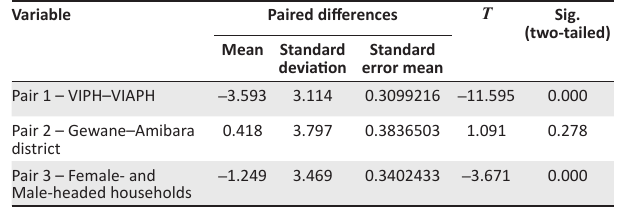
FIGURE 2: Vulnerability levels of households by district. TABLE 6: Paired sample tests for household vulnerability index clustered by livelihood strategy, districts and gender of the household